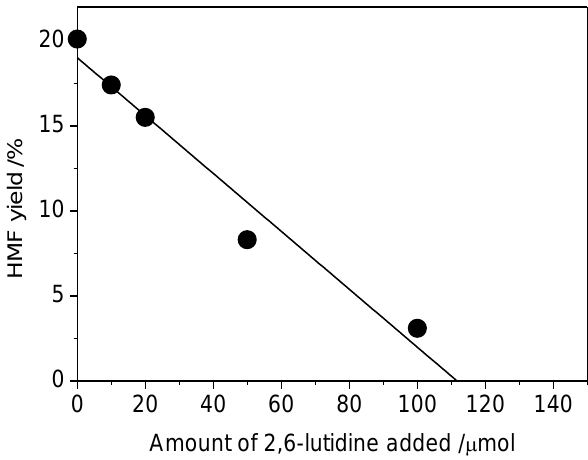
Figure 1. Correlation between HMF yield and amount of 2,6-lutidine added. Reaction conditions :